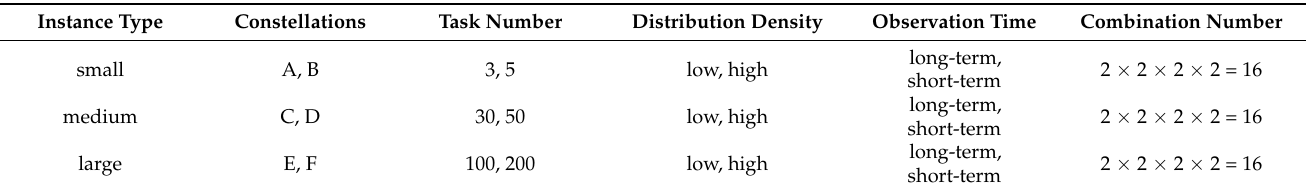
Table 4. Parameter size for each instance